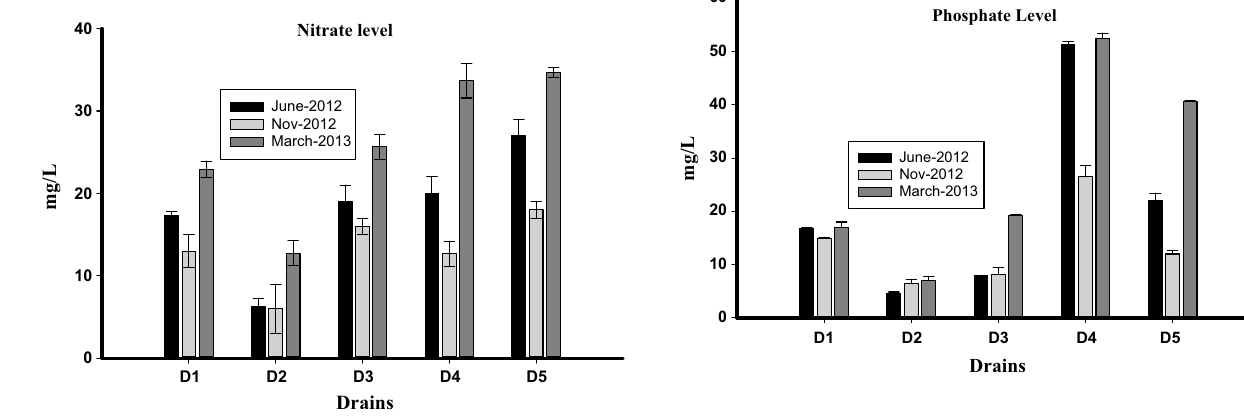
(Fig. 5). During June and March, the phosphate levels of the effluent samples obtained from D4 were 51.4 mg/L and 52.5 mg/L, respectively. The phosphates levels for D4 were greater than all other effluent samples.